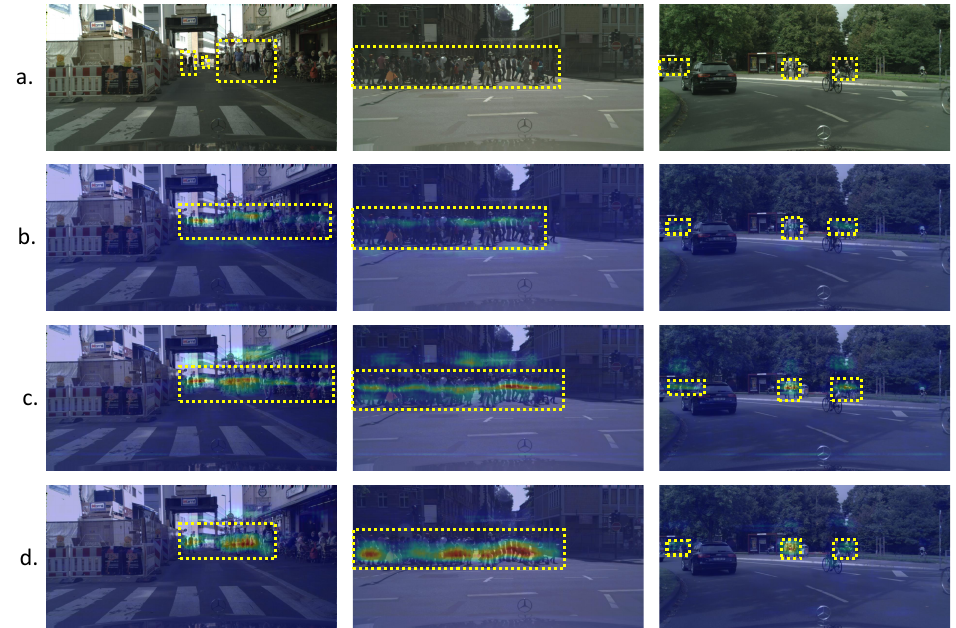
Figure 7. Visualization results of ACFPN, CSP, and CCFNet. ( a ) Input the original image for the CityPersons dataset; ( b ) is the visualization result of ACFPN; ( c ) is the visualization result of CSP; ( d ) is the visualization result of